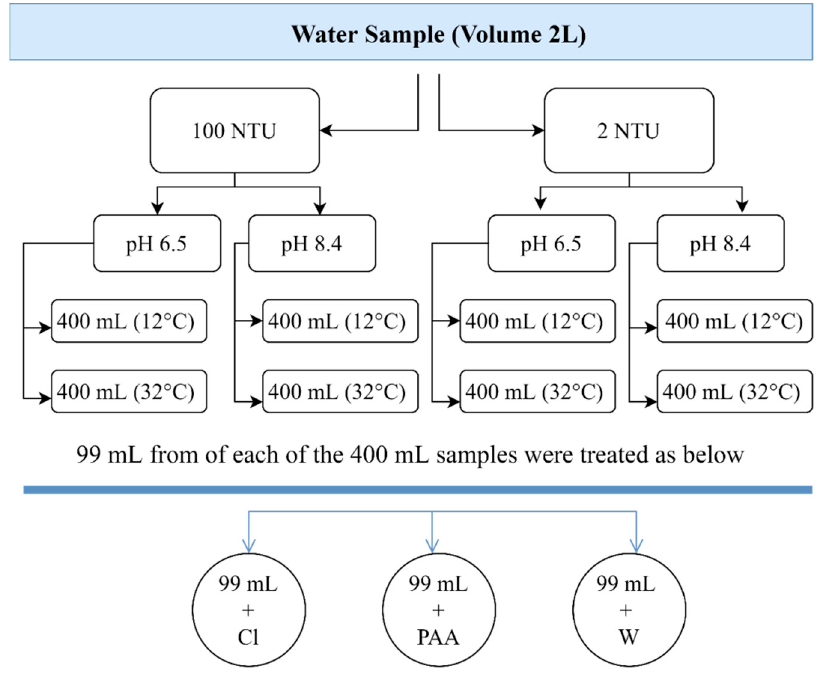
Figure 1. Flow chart of the inoculated water sample preparation and treatment at two pH and temperature levels. Six (99 mL) bottles made from one pH level were treated at the same time.